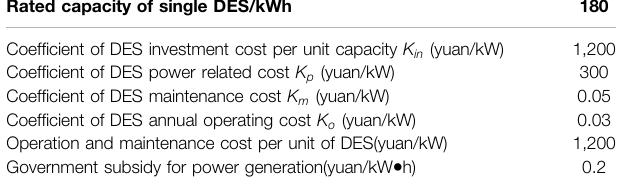
TABLE 2 | DES relevant